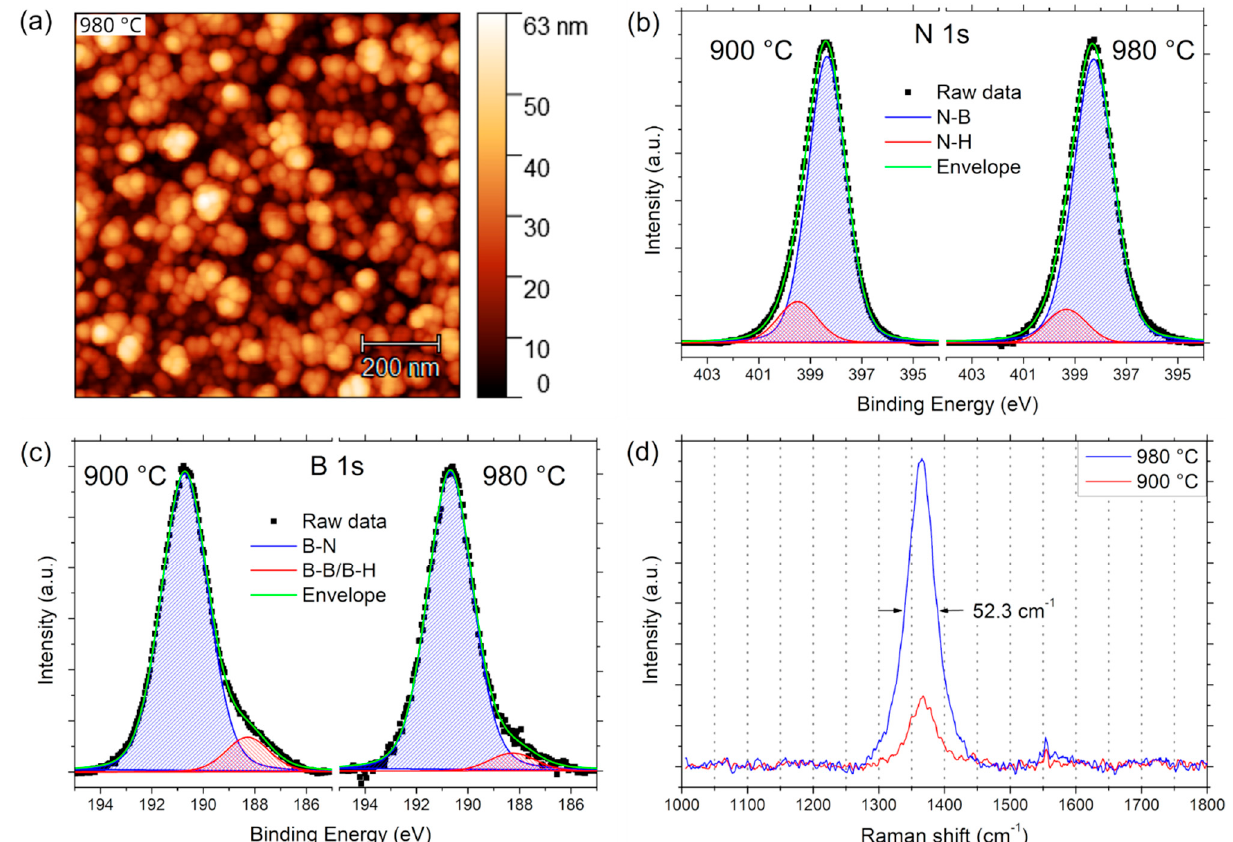
Figure 5. hBN films grown at different temperatures. ( a ) AFM image of sample grown at 980 °C; ( b ) XPS N 1s spectra (Tougaard background subtracted); ( c ) XPS B 1s spectra; ( d ) Raman spectra.